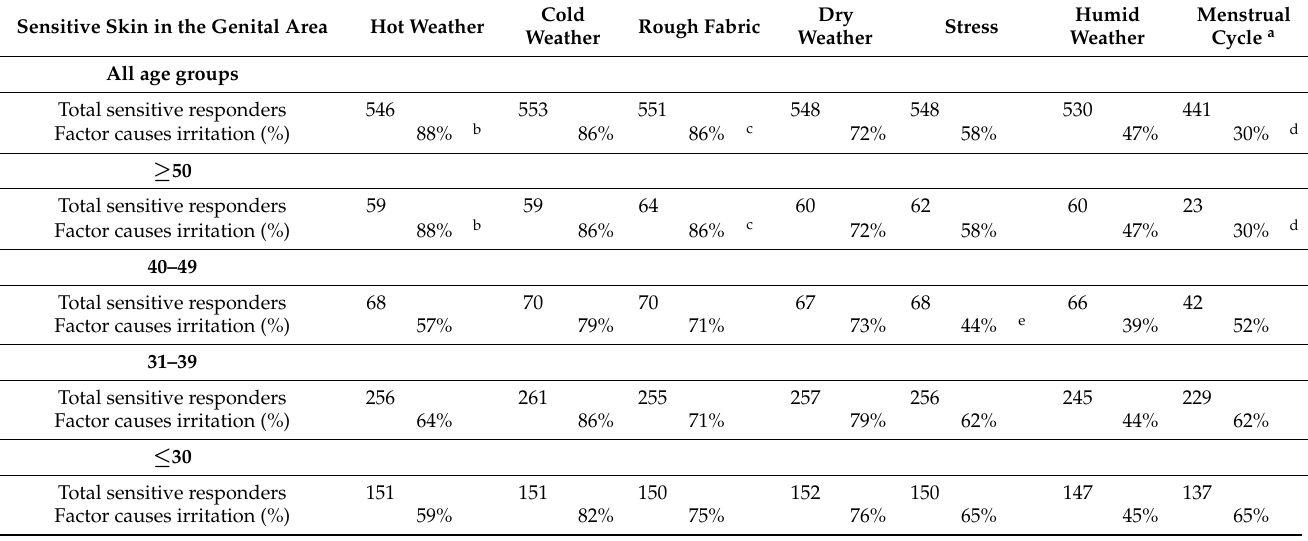
Table 8. Perceptions about triggers of SSS for those claiming genital skin